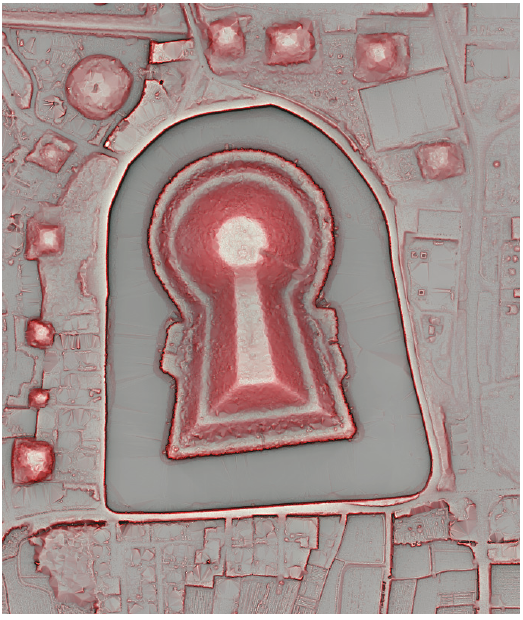
Fig 5. Konabe Mounded Tomb (RRIM of Lidar data)